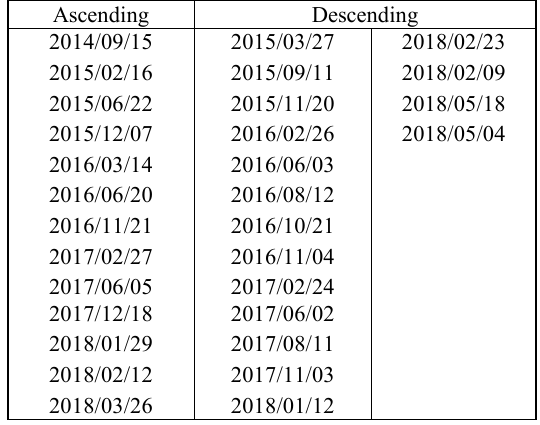
Table 1. Observation dates of PALSAR-2 images used for